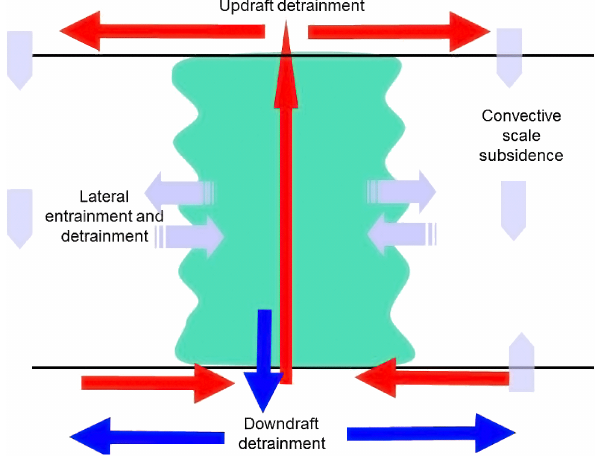
Figure 1. Conceptual picture of a convective